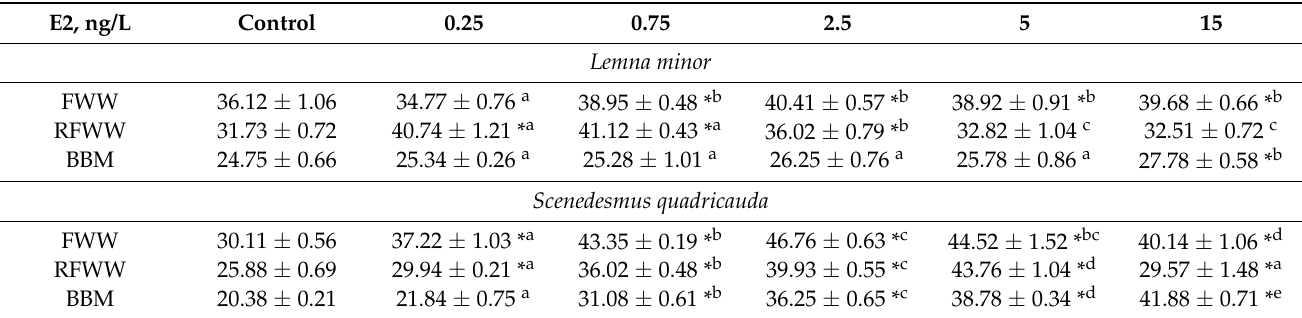
Table 2. Protein (mg/g frw) accumulation in L. minor grown in three different media on the day of the test termination (day